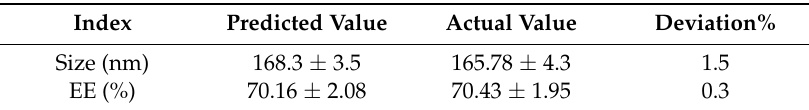
Table 4. Comparing the predicted values and actual values.